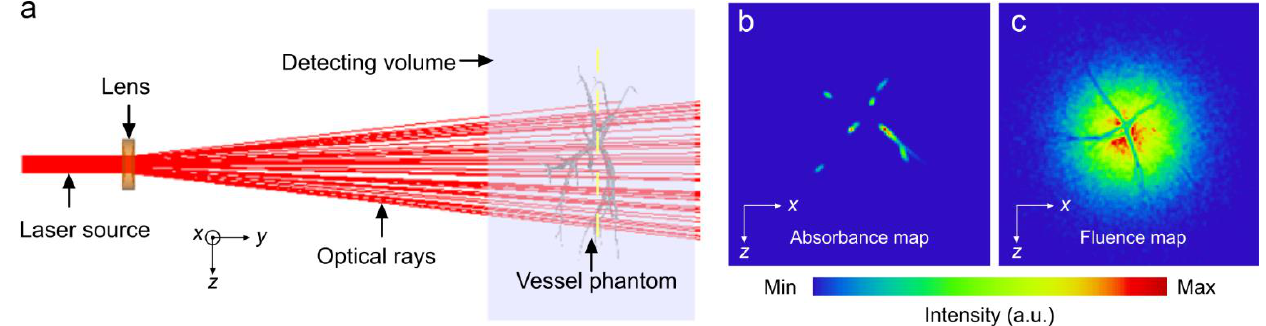
Figure 3. Optical illumination modelling using Zemax. ( a ) Three-dimensional model of Zemax simulation, the yellow dashed line corresponds to the plane shown as ( b ) absorbance map, and ( c ) fluence map.